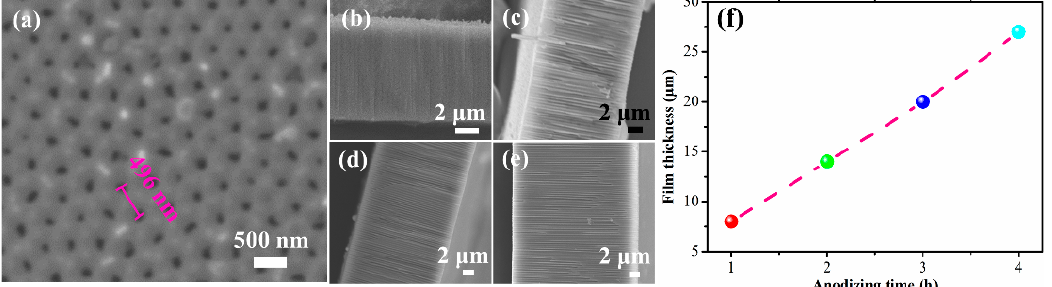
Figure 3. ( a ) Top view of the anodized alumina oxide (AAO) film; ( b–e ) cross-section of AAO film grown at different anodizing times (1 h, 2 h, 3 h, 4 h); and ( f ) curve correlating AAO film thickness with anodizing time.